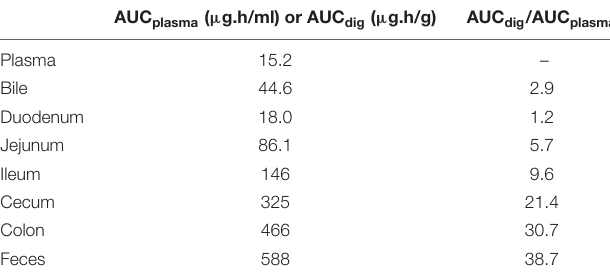
TABLE 2 | AUC plasma , AUC dig , and AUC dig /AUC plasma ratio over 24 h following a single intravenous administration of 8 mg/kg minocycline to 15